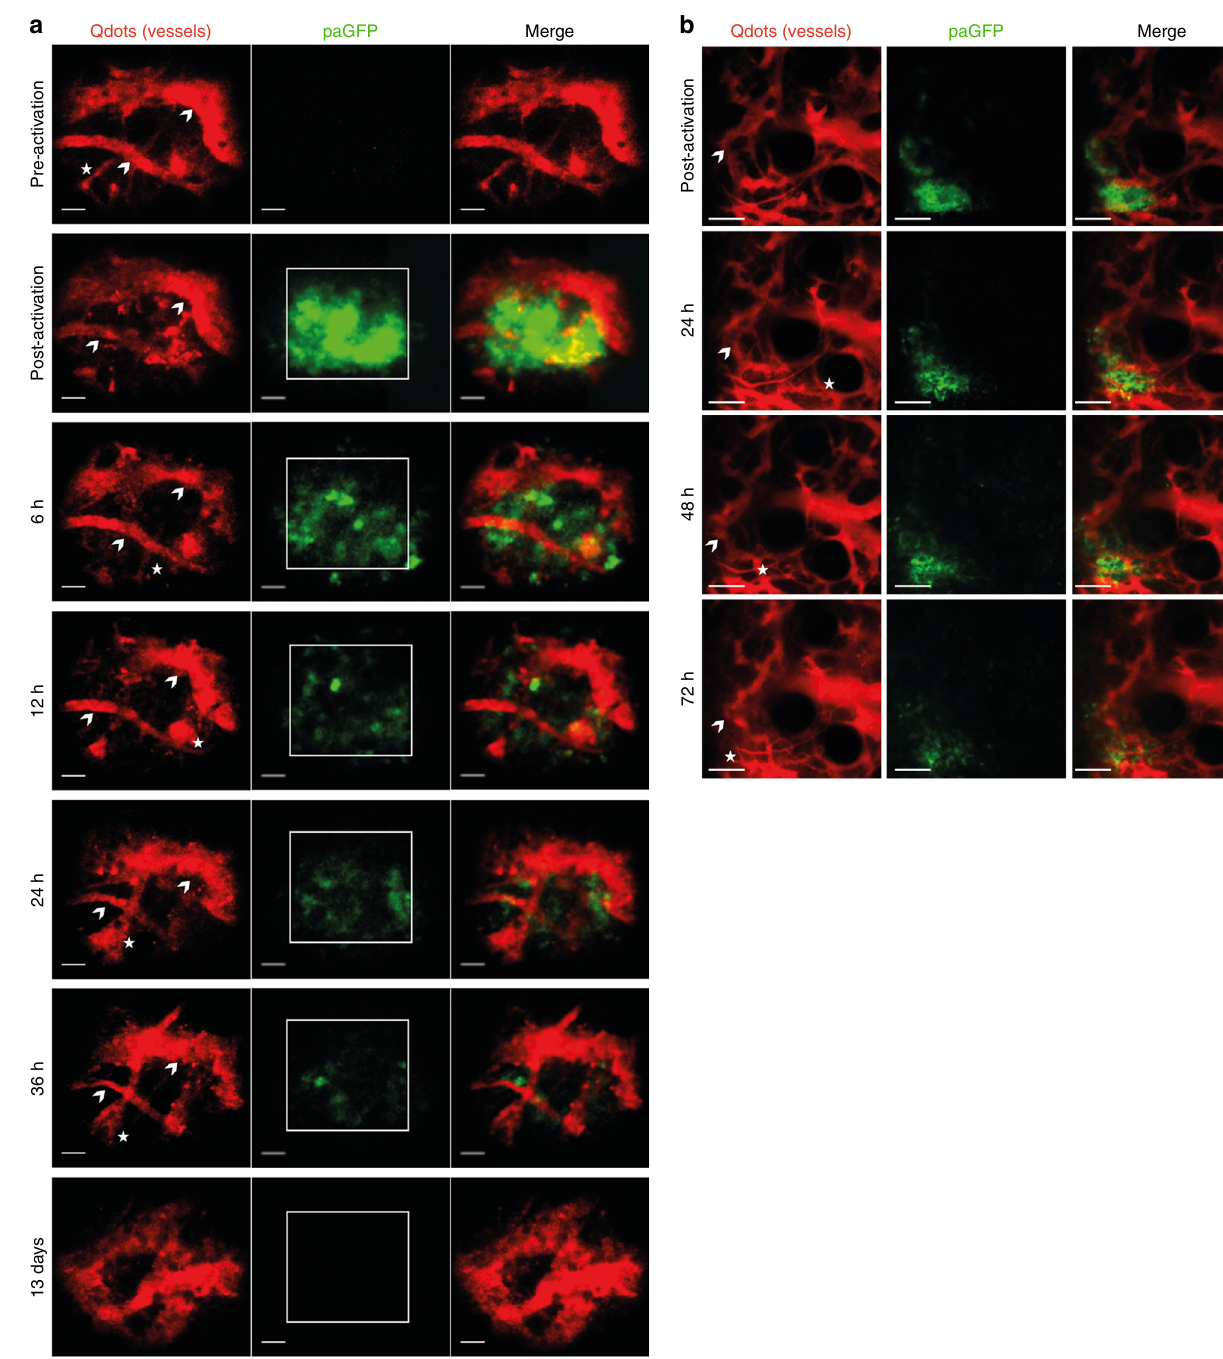
Fig. 5 Imaging of locally activated paGFP in murine deep femoral marrow reveals high positioning stability of the LIMB implant. a paGFP mice were implanted with a LIMB microendoscope ( n = 3 mice). After 35 days, the mice were injected intravenously with Qdots to label the vasculature. Photoactivation of paGFP was performed at a wavelength of 840 nm in a 75 × 75 × 30 µ m 3 square area in the center of the fi eld of view. Additional injections of Qdots were given before each recording. We performed the described photoactivation experiments repeatedly, up to three times in the same animal at day 27, 35, and 56 post-surgery, during homeostasis with similar results. Blood vessels which could be observed over the whole period of 36 h are indicated by arrowheads, whereas those that appear or disappear within this time period are labeled by asterisks. Scale bar = 30 µ m. b Similarly to a , photoactivation of a 150 × 150 × 9 µ m 3 region within the 500 × 500 × 66 µ m 3 fi eld of view in a paGFP mouse with a permanent calvarial imaging window let us easily identify the photoactivated area. The paGFP fl uorescence could be visualized over several imaging sessions. Scale bar = 100 µ m. During these time windows we observed changes of the vasculature in both, the deep femoral marrow and bone marrow islets of the